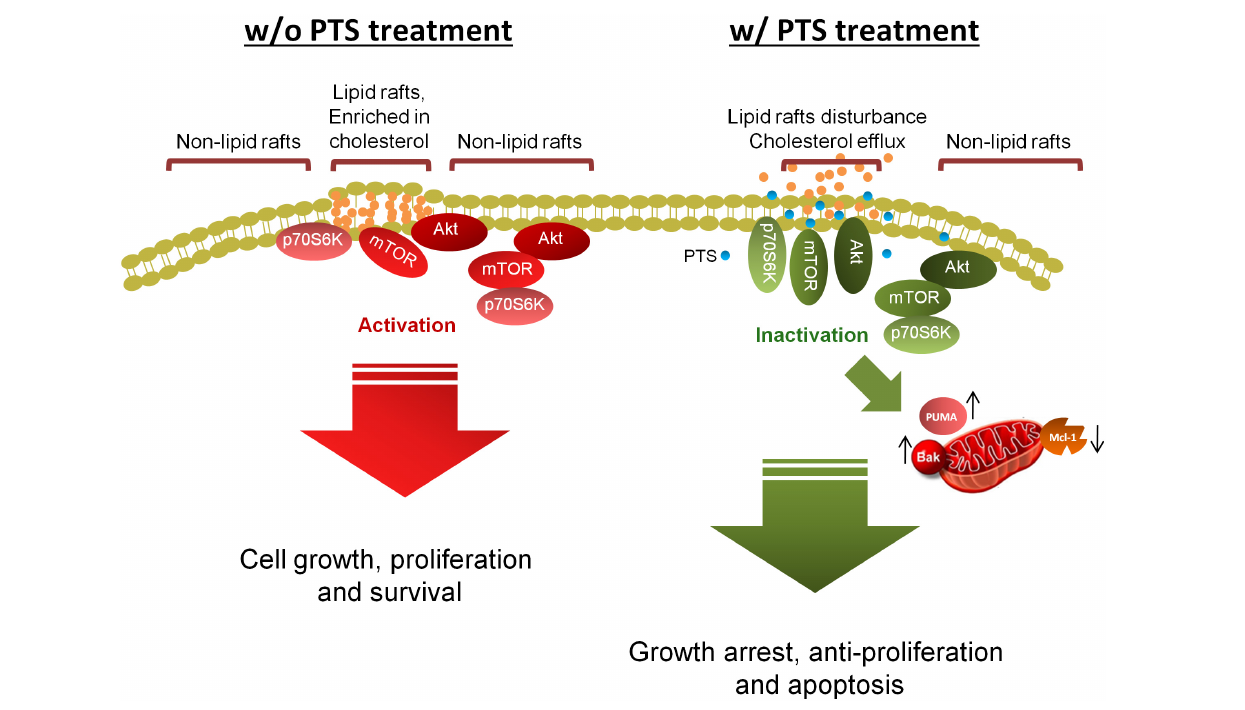
FIGURE 8 | Schematic figure for PTS-mediated signaling pathways. PTS induces anticancer effect through an arrest of the cell cycle at G1 phase and apoptosis via down-regulation of Mcl-1 and up-regulation of both Bak- and PUMA which induce mitochondrial dysfunction in CRPC cells. Furthermore, both Akt-dependent and -independent mTOR/p70S6K pathway are involved in PTS-mediated pathways. Disturbance of lipid raft and cholesterol contents may, at least partly, explain the dissociation and inactivation of Akt, mTOR, and p70S6K in CRPC cells.